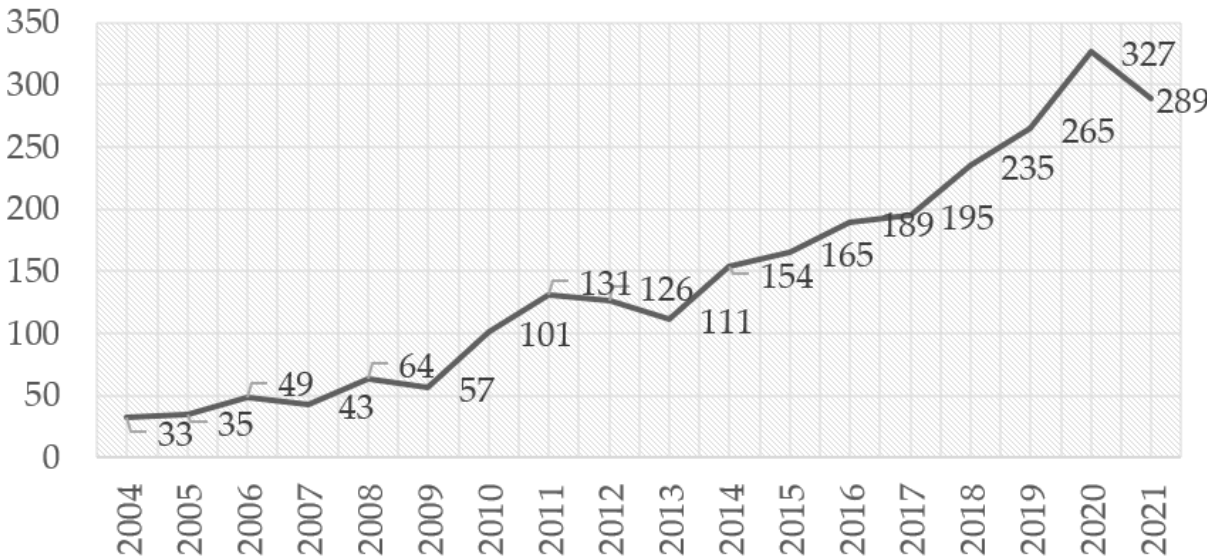
Figure 1. Number of articles published on the topic of rural-to-urban migrants from 2004 to 2021. Table 1. Primary information and summary of the dataset.